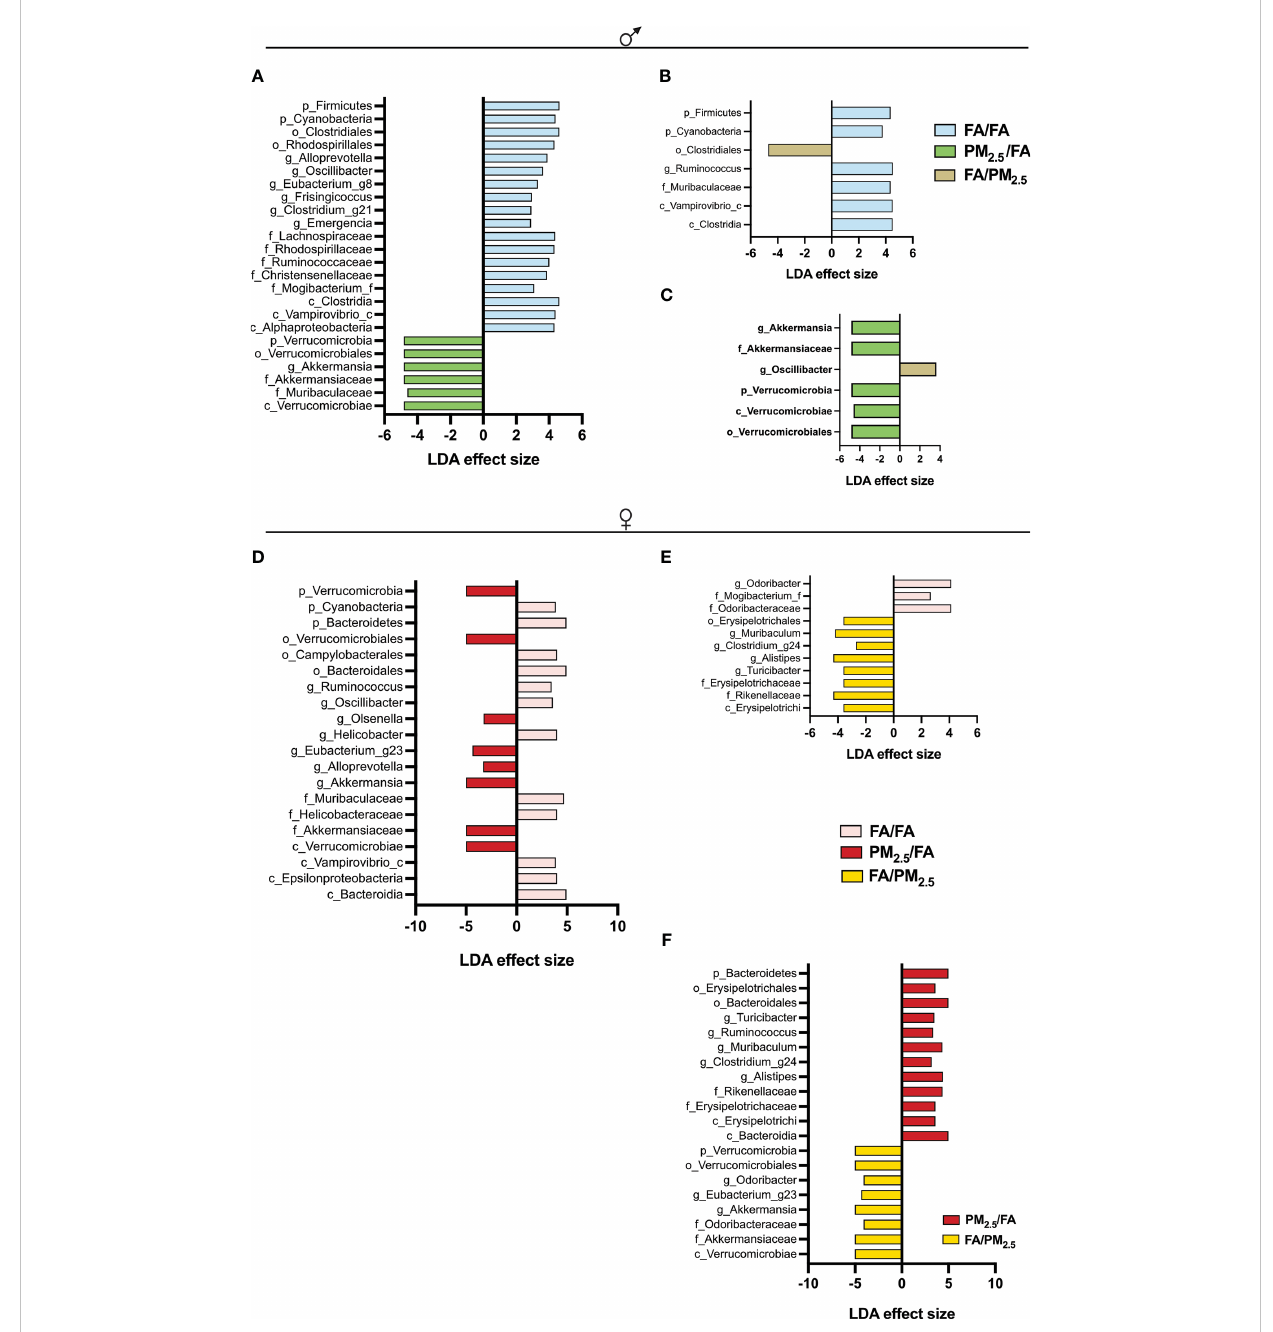
FIGURE 4 Maternal PM 2.5 exposure alters the Linear discriminant analysis (LDA) effect size indicating differences in phyla and genera between (A) FA/FA and PM 2.5 /FA; (B) FA/FA and FA/PM 2.5 ; (C) PM 2.5 /FA and FA/PM 2.5 groups of males. LDA between (D) FA/FA and PM 2.5 /FA; (E) FA/FA and FA/PM 2.5 ; (F) PM 2.5 /FA and FA/PM 2.5 groups of females. Offspring mothers were exposed to PM 2.5 during pregnancy (PM 2.5 /FA) or lactation (FA/PM 2.5 ) and fi ltered air during pregnancy and lactation (FA/FA) as a control group. All mice were 30 weeks of age. The taxa with LDA score > 2 and signi fi cance of <0.05 were determined by the Wilcoxon signed-rank